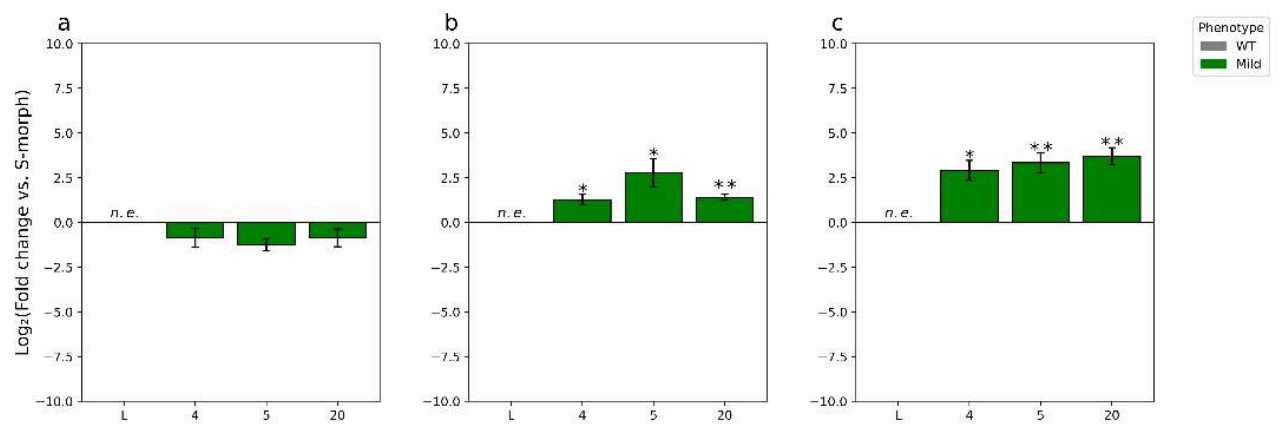
Figure 8. RT-qPCR analysis of the expression of TjYUC6 in T 1 lines compared to WT S-morph during early floral development ( a ), late floral development ( b ), and the pollen from dehisced anthers ( c ). N = 3 biological replicates, n.e. = not expressed, * = p -value < 0.05, and ** = p -value < 0.01. p -values determined by Student’s t -test comparing the ∆ CT of the respective transgenic line with that of the WT S-morph. Error bars represent the standard error of the fold change. Values represent the log2(fold change).